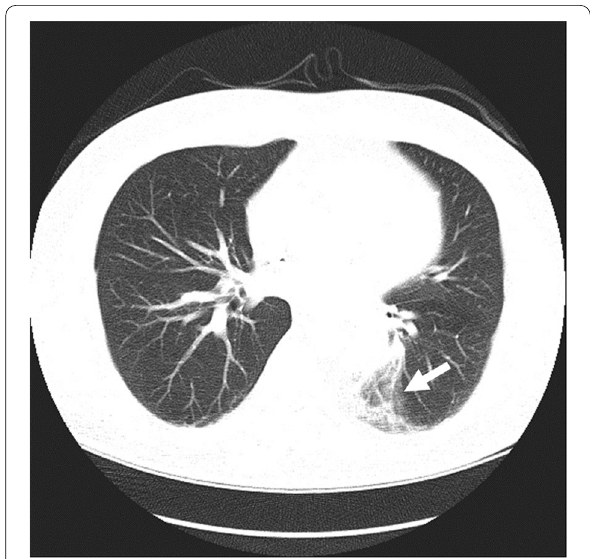
Fig. 1 Spiral chest CT depicted a consolidation in posterior aspect of left lung